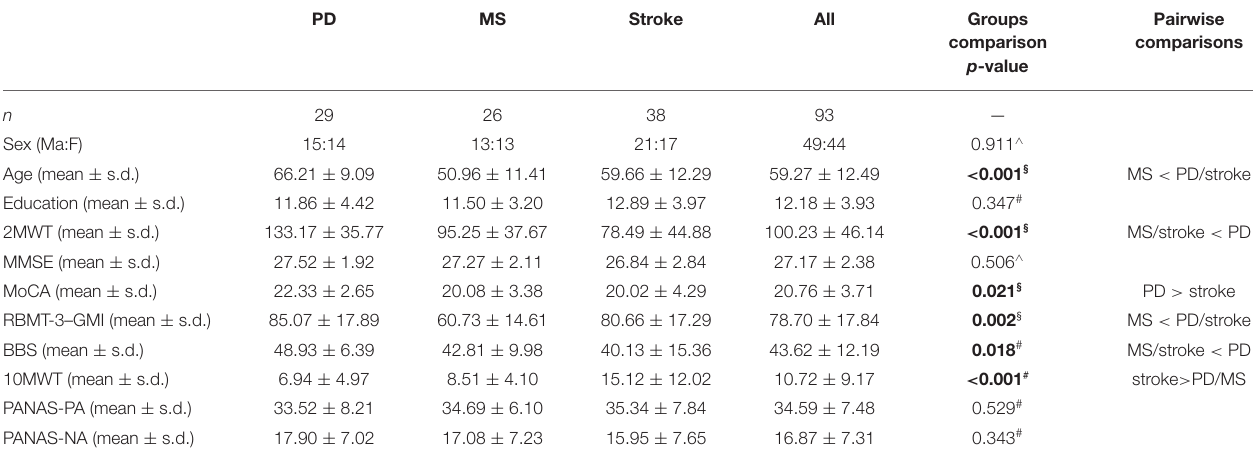
TABLE 1 | Description of sample characteristics at baseline.